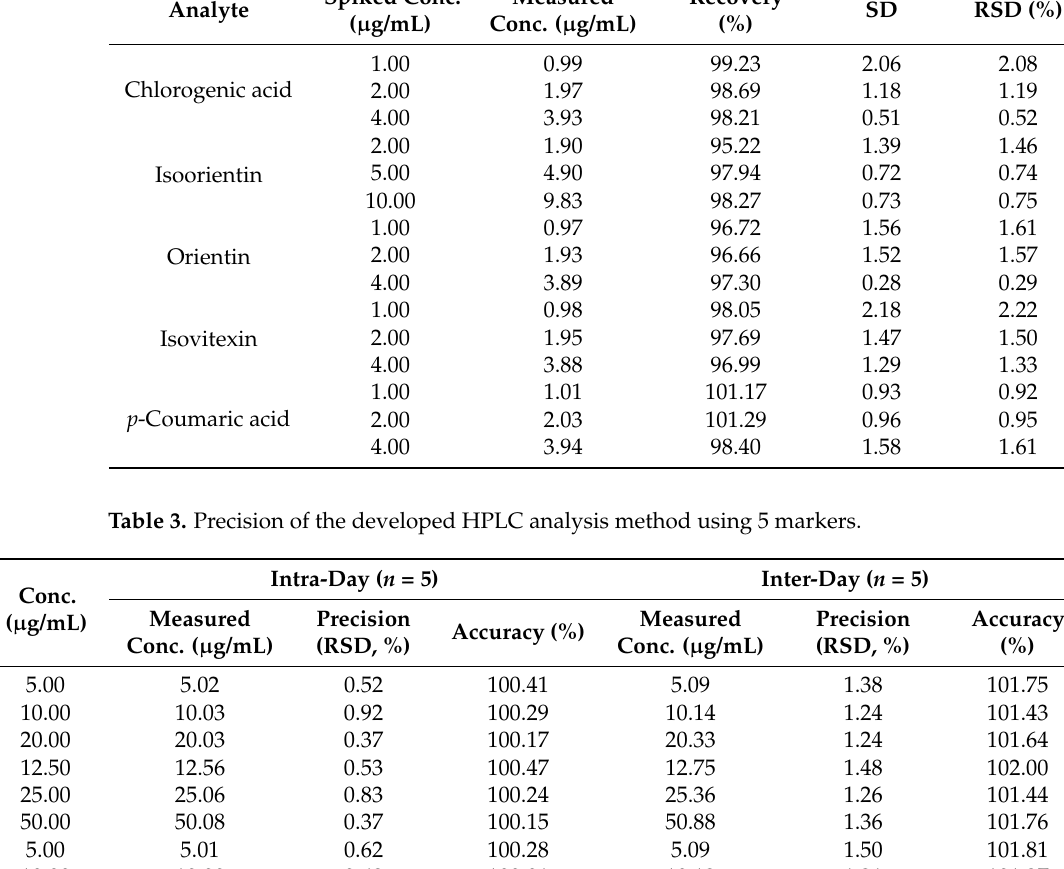
Table 2. Recovery (%) of the five marker analytes in the developed HPLC assay ( n = 5). Analyte